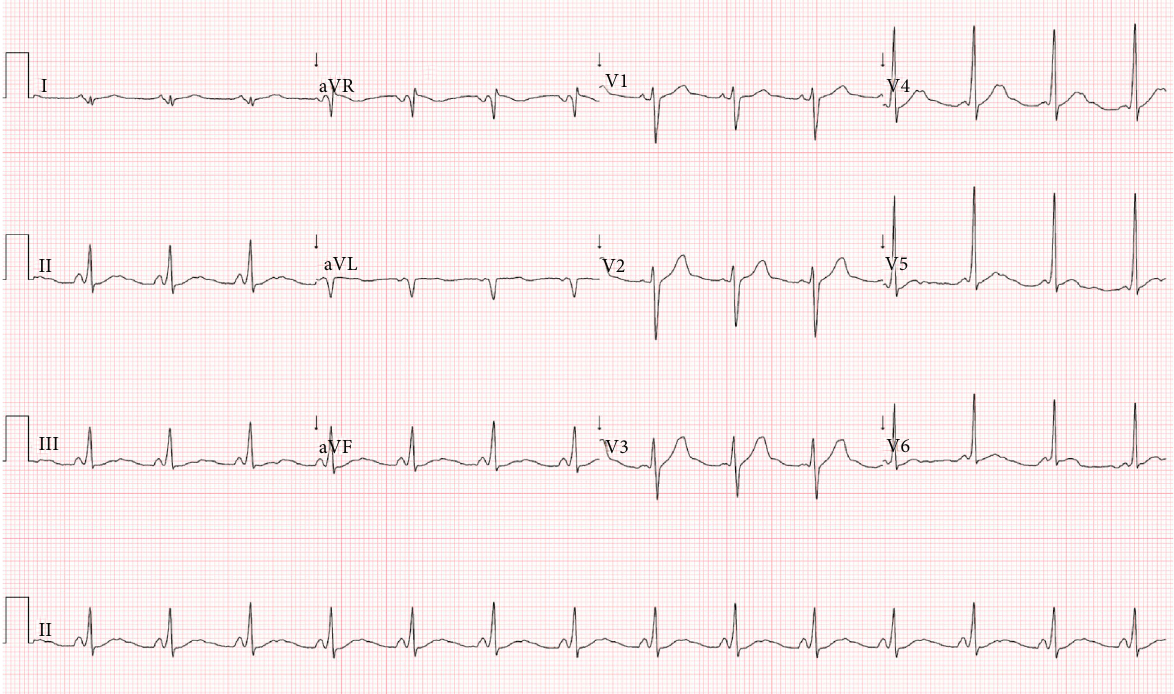
Figure 3: Twelve-lead electrocardiogram after conversion to sinus rhythm (=baseline electrocardiogram). Shortened PR interval, delta wave, and secondary repolarization abnormalities are seen. This ECG is indicative of WPW syndrome, and a left anterolateral AP is suggested by negative QRS in V1 lead, QS complex in aVL lead, and positive delta wave in V3-V6 leads and inferior leads.